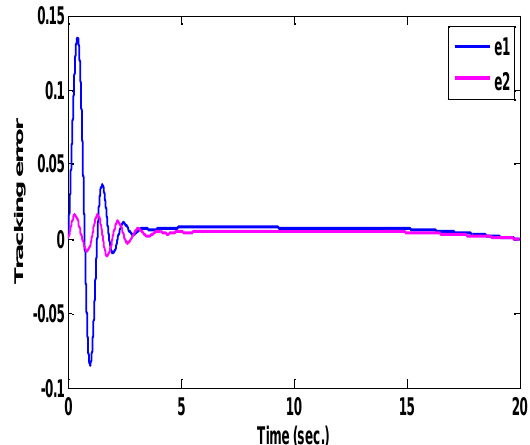
Figure 4. Tracking performance of proposed approach.